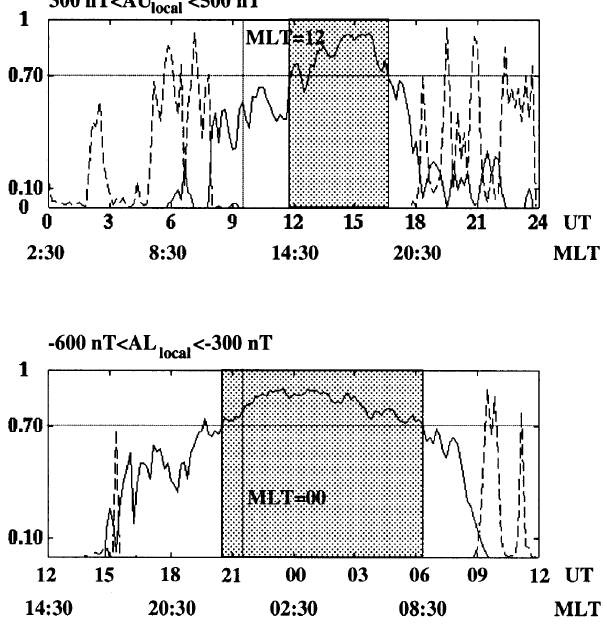
Fig. 7. Correlation ( solid line ) and an estimate for its statistical significance ( dashed line ) between the global and local A ” ( upper panel ) and A ‚ ( lower panel ) indices. The correlation can be con- sidered as significant when the dashed line is below 0.01. The gray shadings show the UT-periods when the correlation is better than